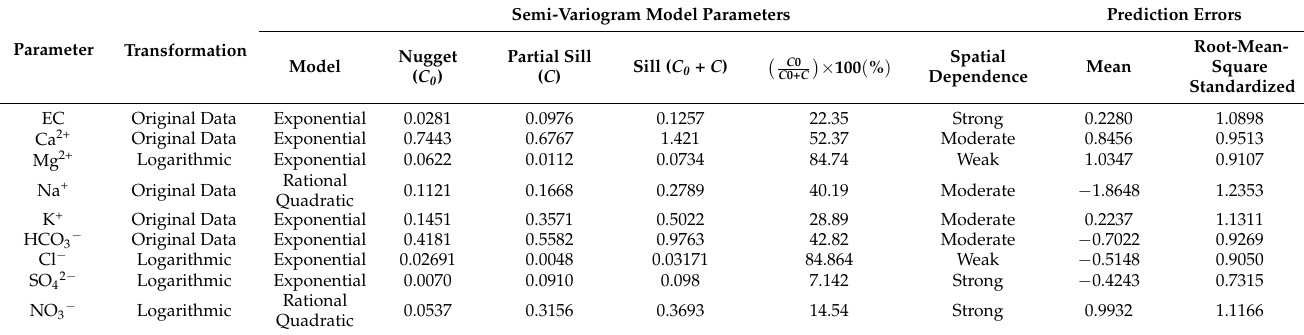
Table 5. Best-fitted semi-variogram models and cross-validation for OK of groundwater quality parameters. Semi-Variogram Model Parameters Prediction Parameter Transformation